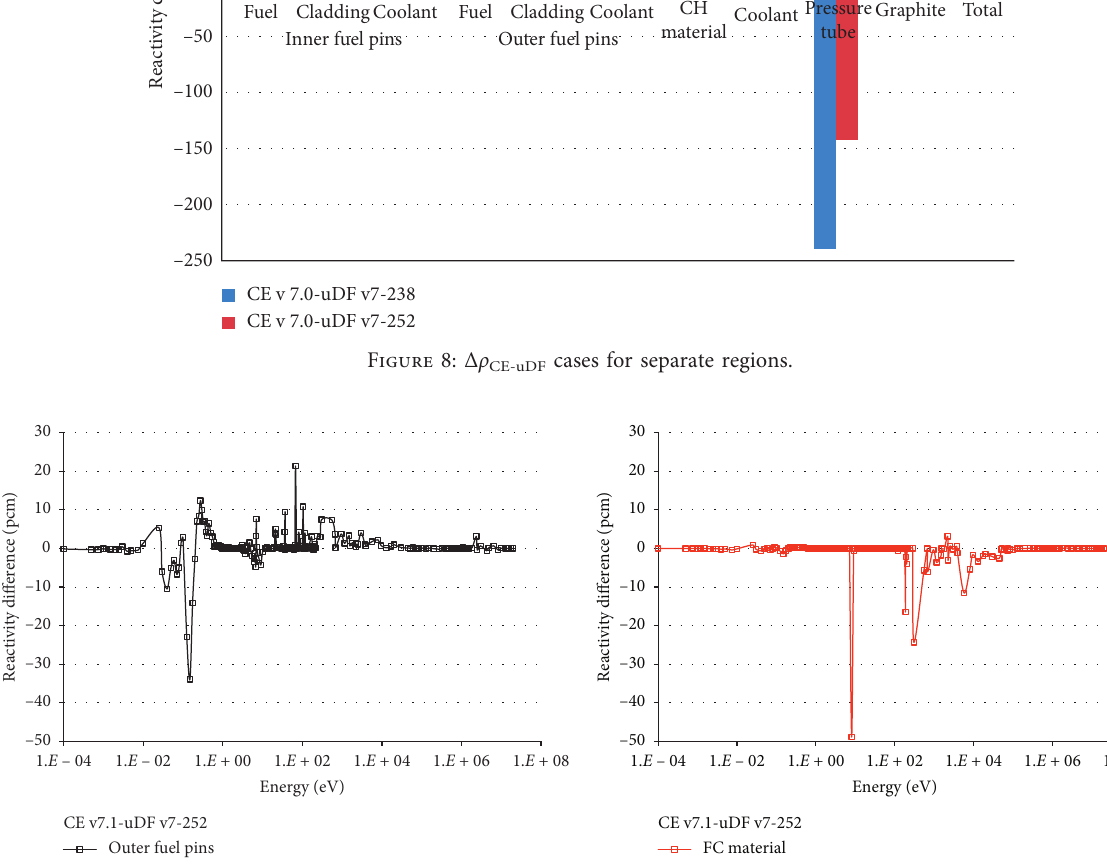
Figure 9: Δ ρ CE-uDF for pressure tube (a) and outer fuel pins (b)